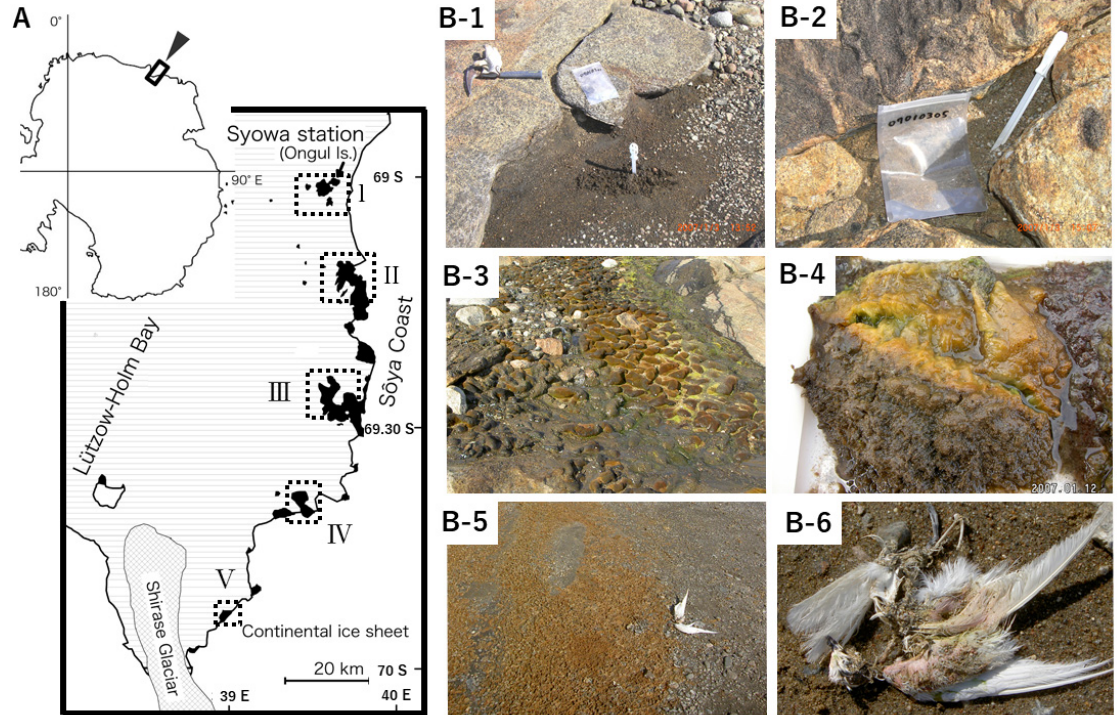
Figure 1. Locations of sampling sites and various terrestrial samples in this study. ( A ) Sampling sites: I: Ongul Is., II: Langhovde, III: Skarvsnes, IV: Skallen, V: Rundvågshetta. ( B ) Example of sampling sites and collected samples: soils in East Ongul Is. ( B - 1 , 2 ), moss colonies in Skarvsnes ( B - 3 ), algal mats from the bottom of freshwater lakes in Skarvsnes ( B - 4 ), dried algal mats ( B-5 ), and dead birds near freshwater lakesides in Skarvsnes ( B-6 ).